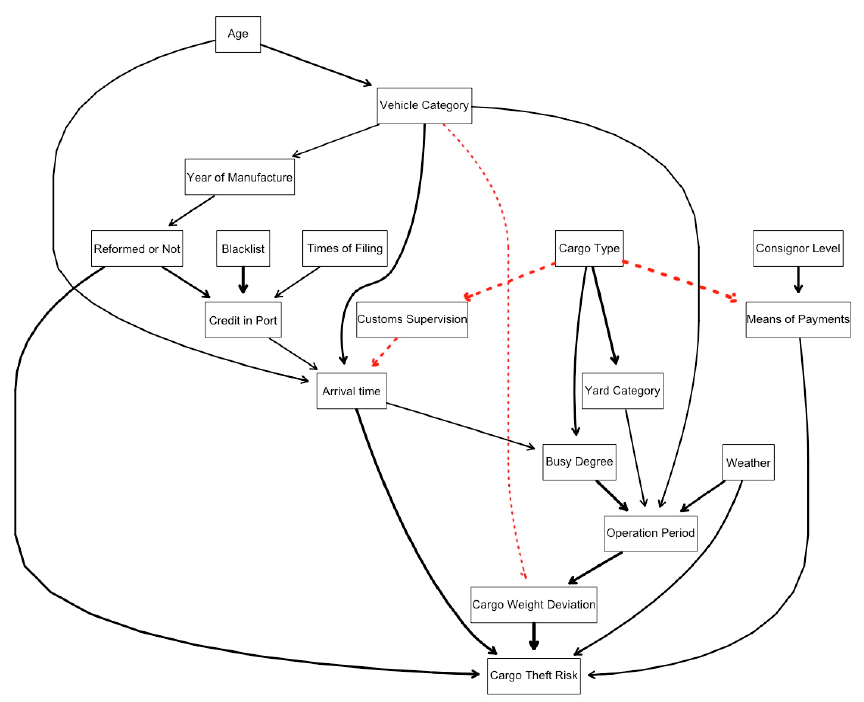
Figure 5. The Bayesian network structure derived using combinations of heuristic structure search algorithm with HC and score function with k2.